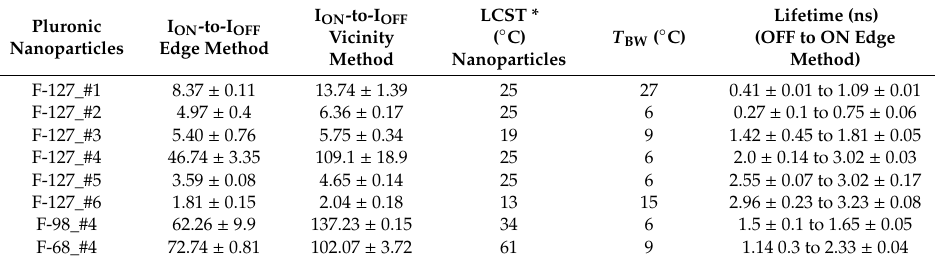
Table 4. Summary of switching properties of the fluorophore-encapsulated Pluronic nanoparticles. Pluronic Nanoparticles